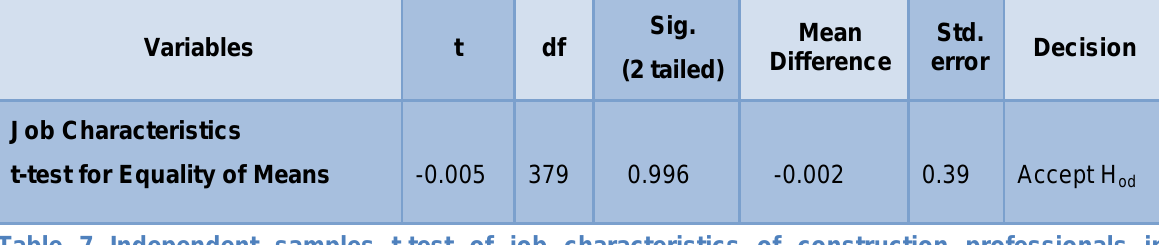
Table 7 Independent samples t-test of job characteristics of construction professionals in indigenous and expatriate construction companies df = Degree of freedom sig. = Significance Std. error = Standard